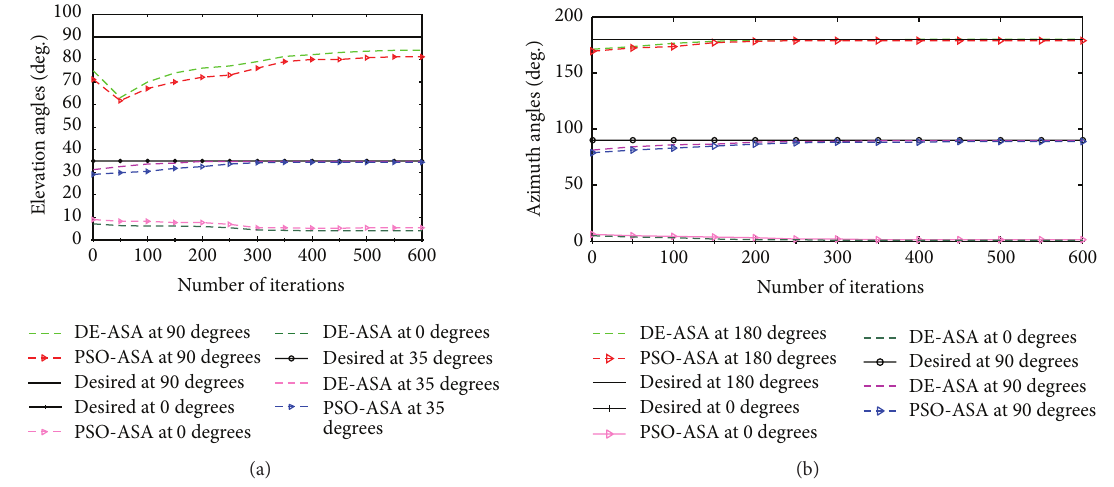
Figure 6: (a) Elevation angle estimation on reference axis. (b) Elevation angle estimation on reference axis.